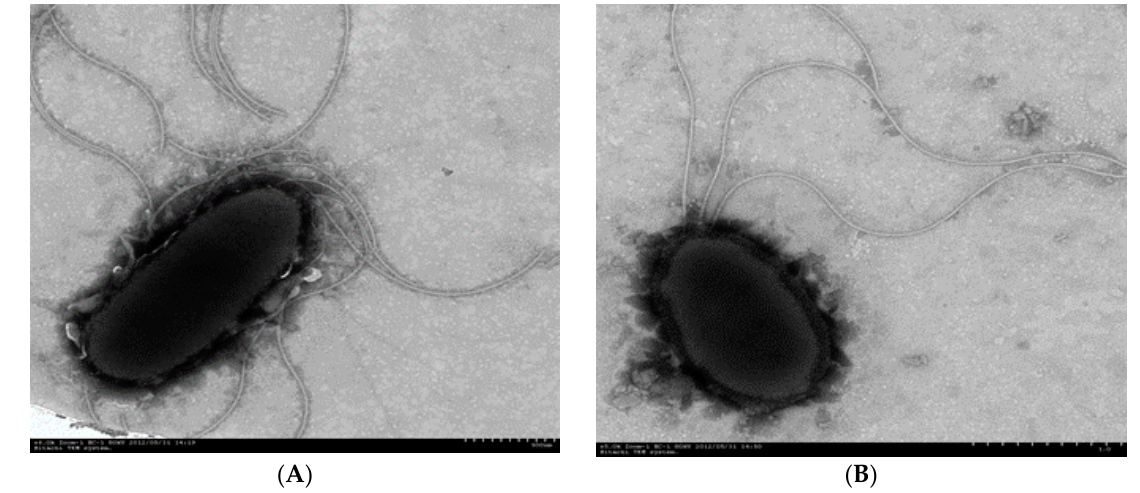
Figure 1. Electron micrographs of strain P 1 (( A ): ×6.0 K Zoom-1 HC-1 80 kV) and strain P 3 (( B ): ×5 K Zoom-1 HC-1 80 kV).